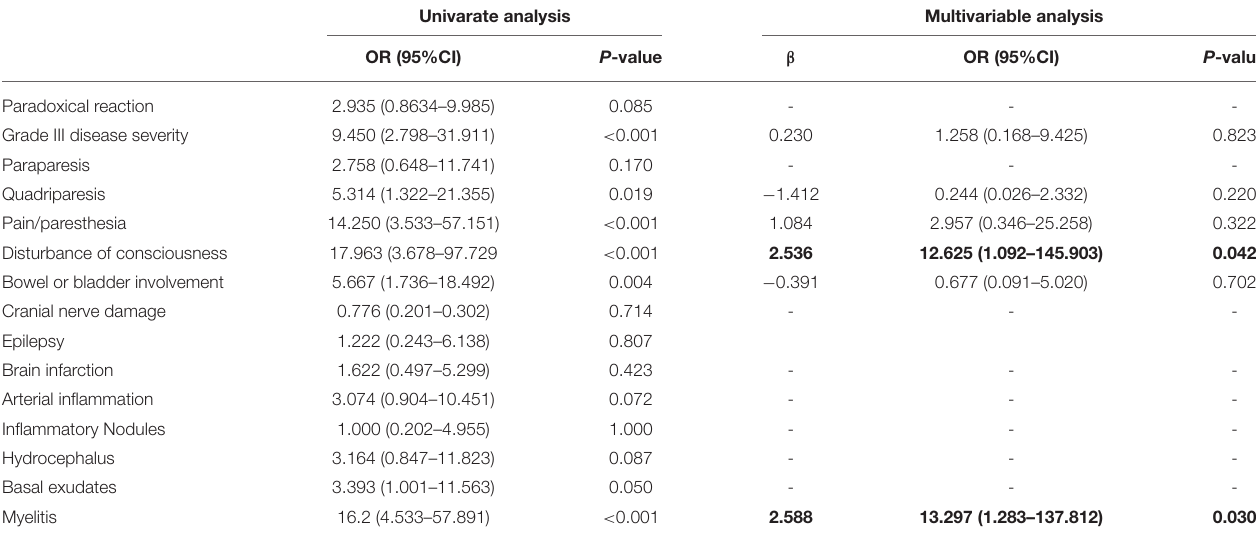
TABLE 4 | The univariate and multivariate logistic regression analysis for the risk factors of poor outcome in patients with